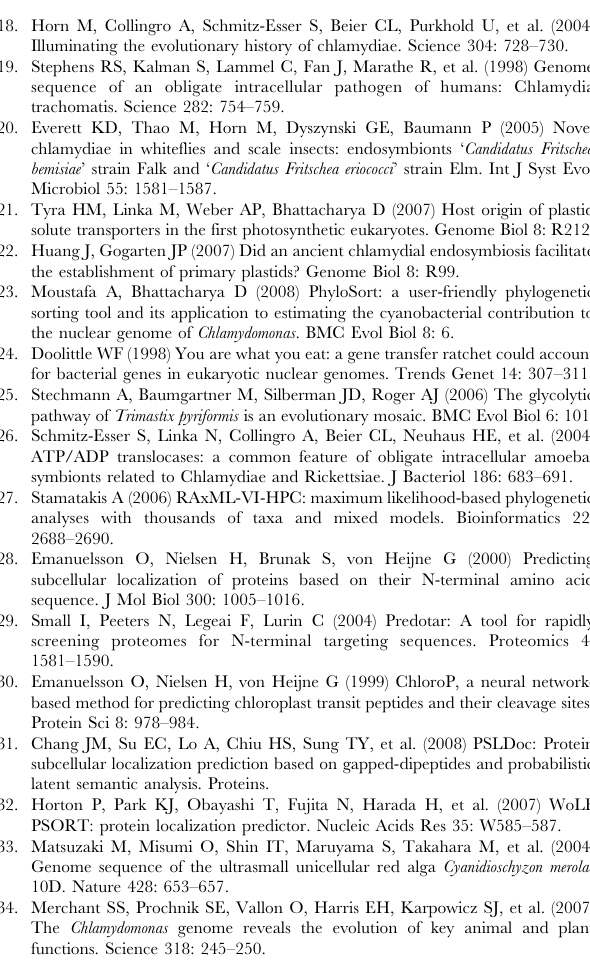
Table S2 The 55 RAxML bootstrap trees that were identified by our phylogenomic analysis to support the monophyly of Chlamydiae and Plantae (with or without chromalveolates). The tree ID (see Table S1) precedes each tree.